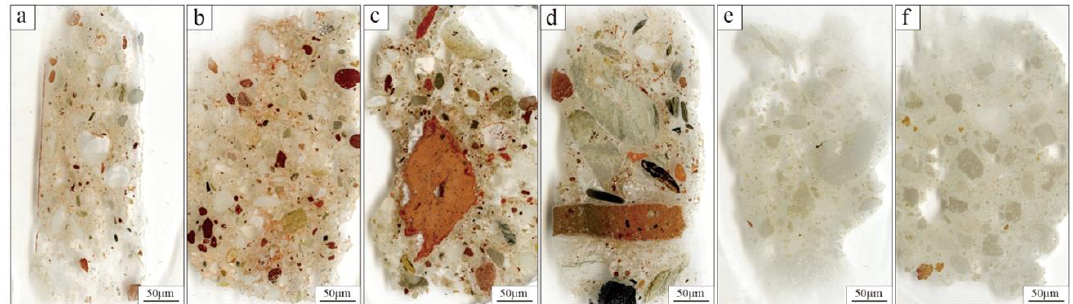
Figure 3. Macroscopic texture of the lime mortars from the Amaiur Castle cistern. ( a ) CA-AL-2, plaster sample. ( b ) CA-AL-8a, ( c ) CA-AL-8b, and ( d ) CA-AL-7, samples from the tank mortars. ( e ) CA-AL-2 and ( f ) CA-AL-5, mortars from the vault. Mortars from the tank show an increase in aggregate grading from the inner part ( d ) to the outer part ( a ).